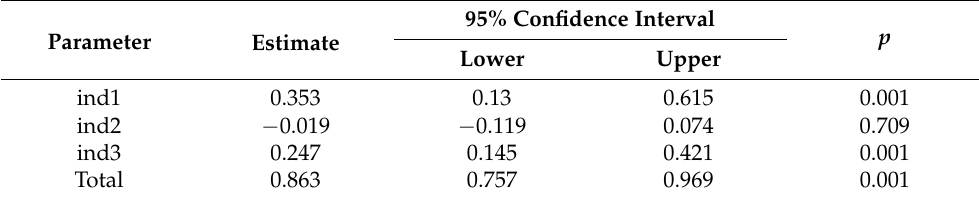
Table 4. Test results for the mediating